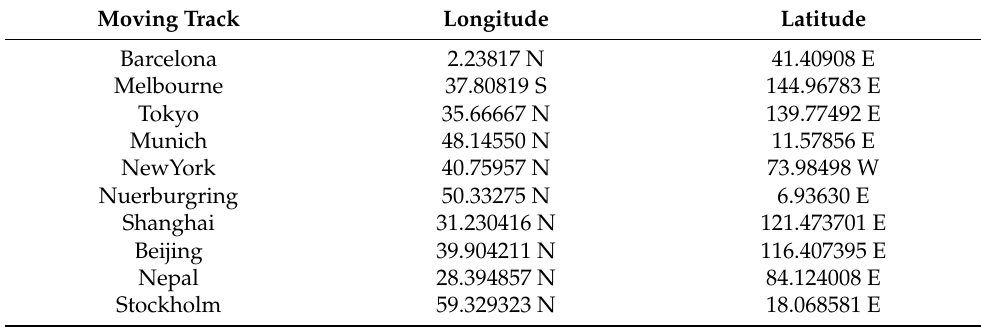
Table 9. CACC test